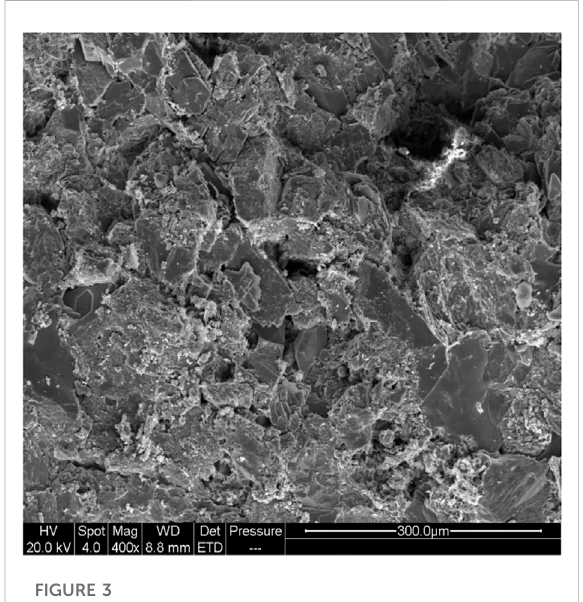
FIGURE 3 Inter-particle pore developed in the core.